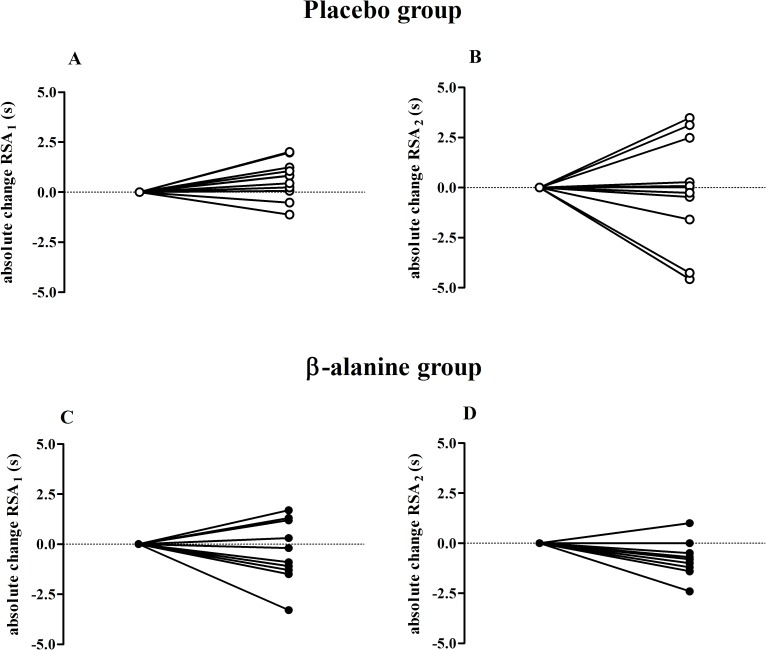
Individual absolute change (post-pre) for the placebo and β-alanine groups in RSA testing.A = Individual absolute change in the placebo group in RSA1; B = Individual absolute change in placebo group in RSA2; C = Individual absolute change in the β-alanine group in RSA1; D = Individual absolute change in the β-alanine group in RSA2. Note: 2 participants in the β-alanine group were excluded from the RSA2 analysis, as shown in Fig 1.